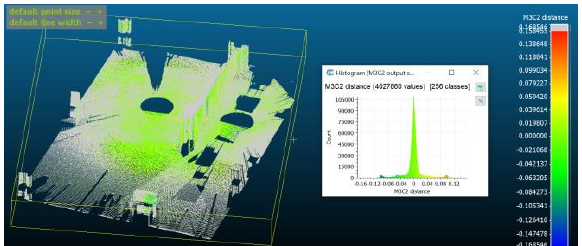
Figure 7: FARO-GeoSLAM comparison